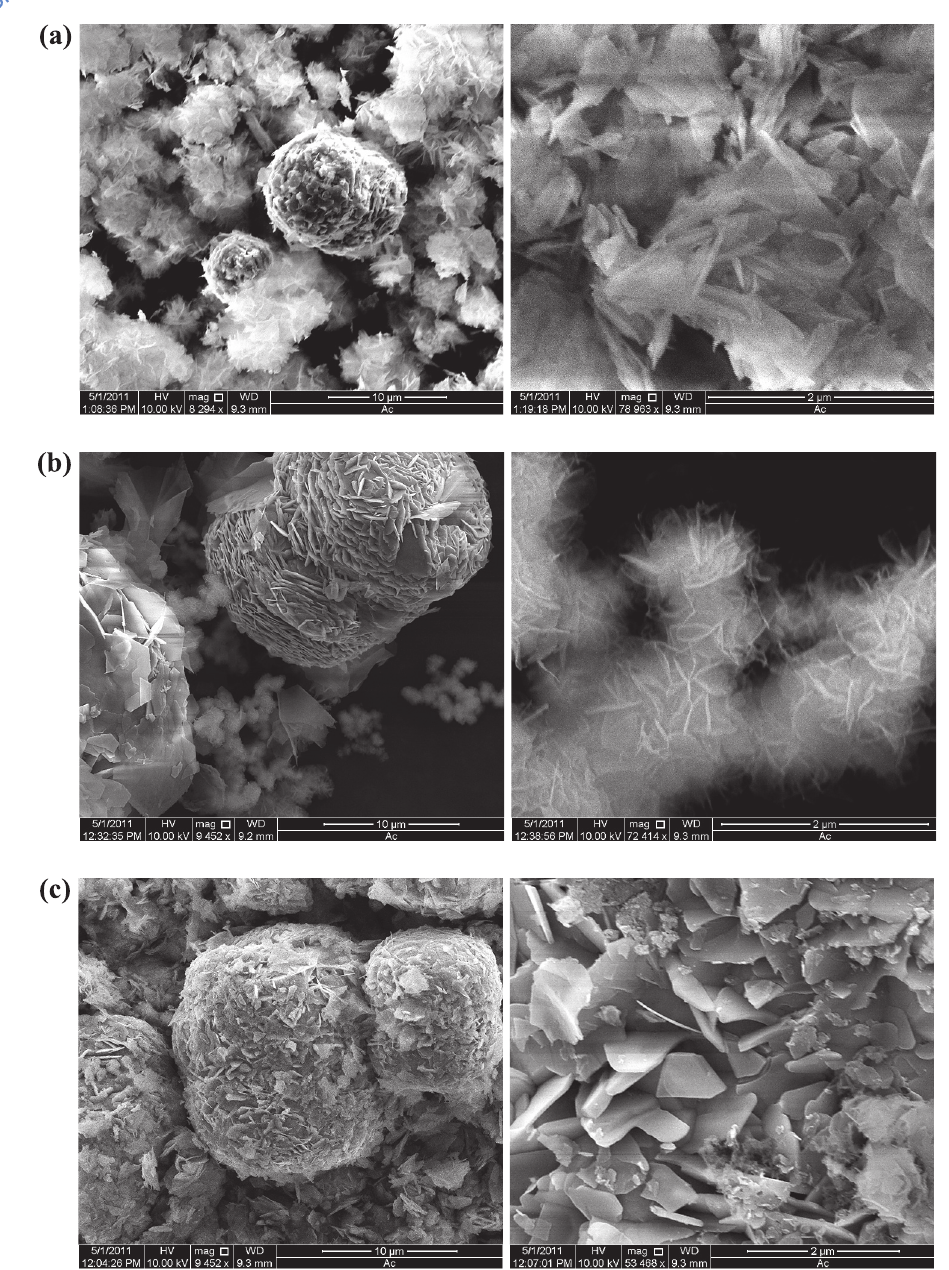
Fig. 4 SEM images showing the morphology of nanocrystalline Zn 0.9-x Ni 0.1 Al x O nanopowders at different mag- nifications: (a) x = 0 at.%, (b) x = 1.5 at.% and (c) x = 2.5